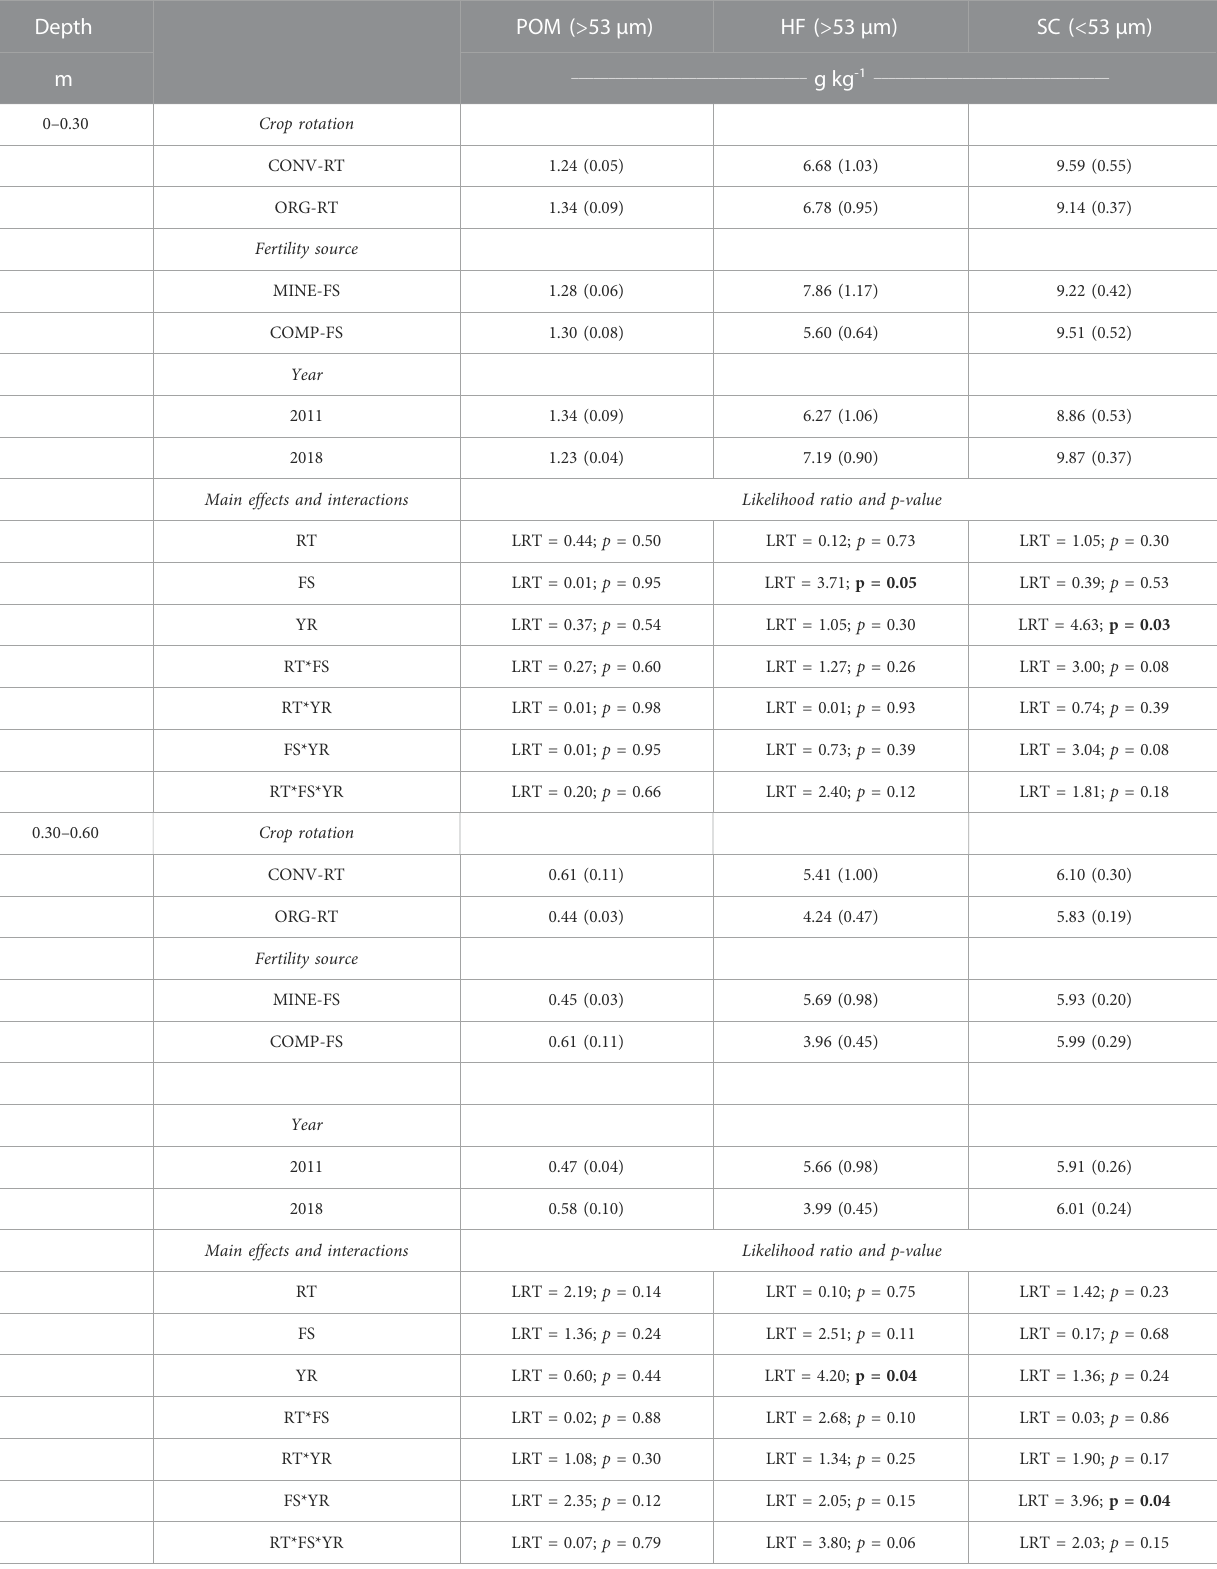
TABLE3Maineffectmeansforcrop rotation(RT)(conventional-CONV-RT vs. organic-ORG-RT),fertility sources(FS)(mineral-MINE-FS vs. compost-COMP-FS), years of sampling (YR) (2011 and 2018). Signi fi cance of the main effects and their interactions on soil organic C concentrations (g per kg -1 soil) in the organic